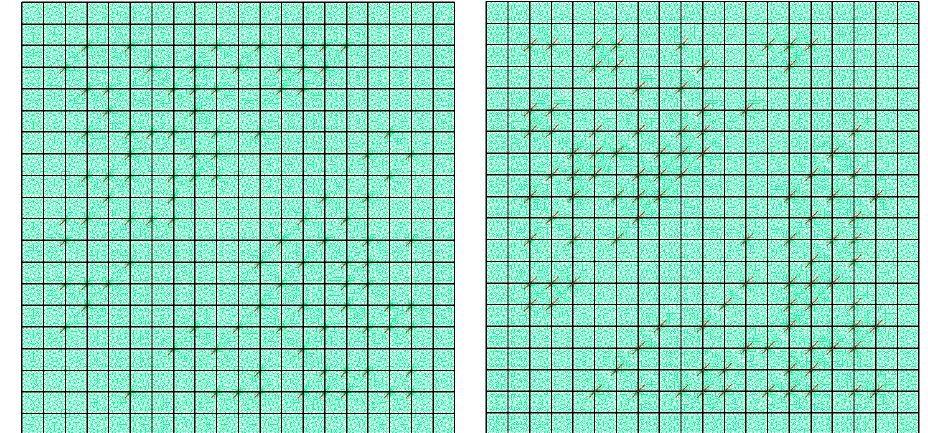
Figure 4. Computational grids for Geometry 1 and 2 with 100 straight fractures. Fractures are depicted in red color. Structured coarse grid (black color) with 400 square cells. Unstructured fine grid (green color) with triangular elements that conformed with fractures. Left: Geometry 1 with fractures length 10 m and 45 ◦ orientation angle.The fine grid contains 31,752 triangle elements. Right: Geometry 2 with fractures length 20 m and 45 ◦ orientation angle. The fine grid contains 32,616 triangle